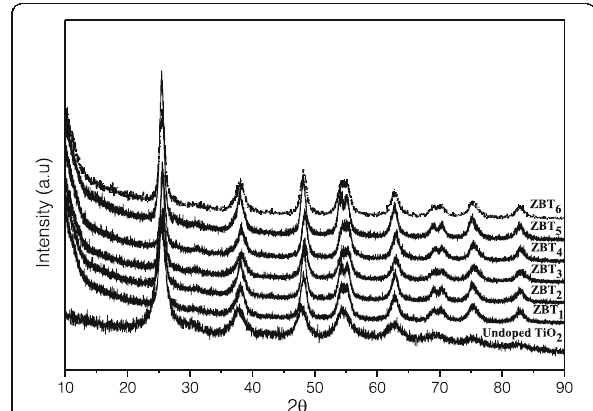
Fig. 1 XRD pattern of the synthesized undoped and co-doped TiO 2 with different wt% of Zn &